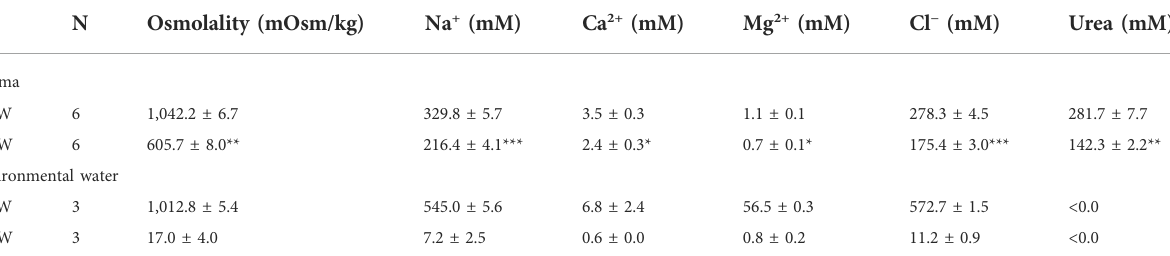
TABLE 1 Plasma compositions of red stingray in Experiment 1